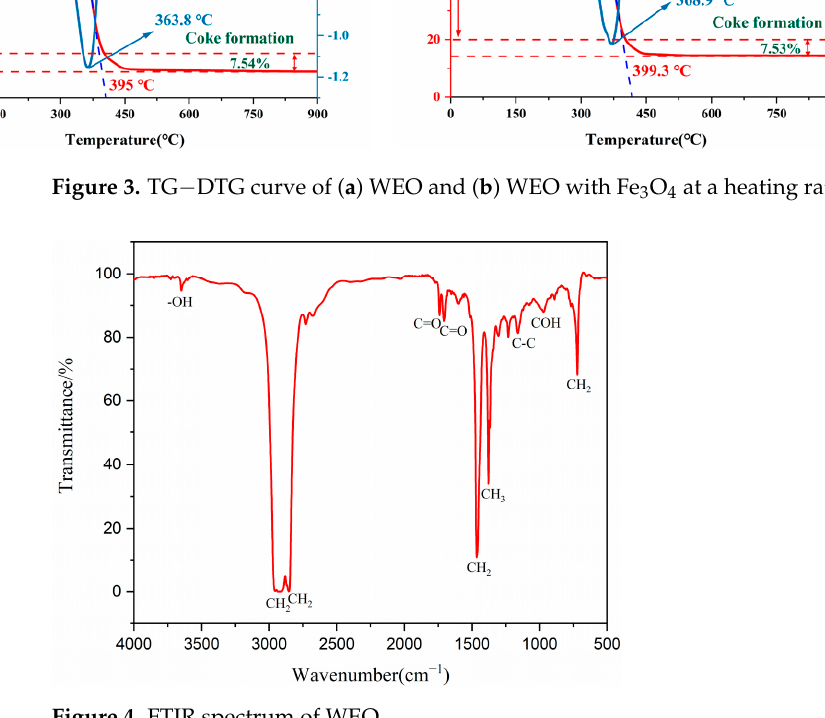
Figure 4. FTIR spectrum of WEO. 3.1.3. Infrared Spectroscopic Analysis of WEO Pyrolysis